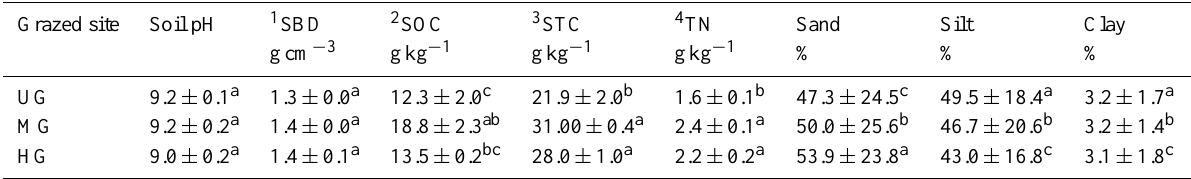
Table 1. Soil characteristics for ungrazed (UG), moderate grazing (MG) and heavy grazing (HG) sites (mean ± standard error) at 10cm soil depth. ( n = 5). Grazed site Soil pH 1 SBD 2 SOC